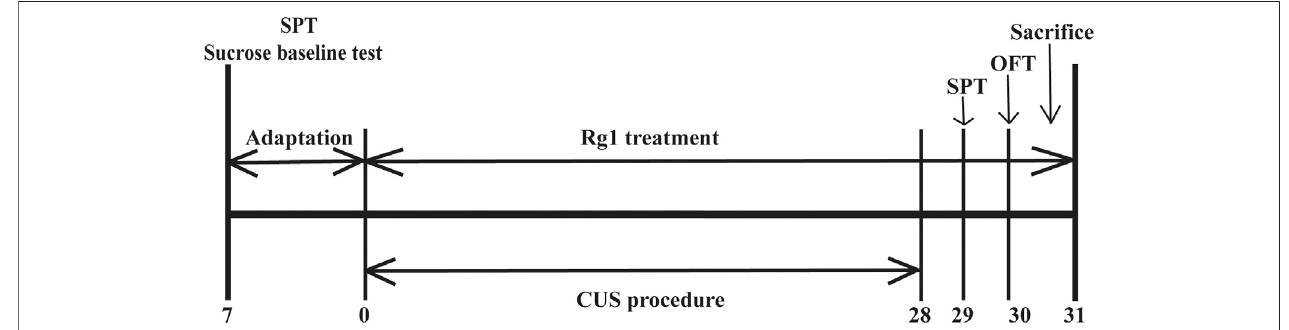
FIGURE1| Theschemeofexperimental designandtimelineforanimals.Rats weresubjectedtoCUSprocedureintheabsenceorpresenceofRg1(40 mg/kg) for 28 days. Behavioral performances of rats were assessed by the SPT and OFT on days 29 – 30, after which the rats were sacri fi ced on day 31 ( n (cid:1) 6 per group). CUS, chronic unpredictable stress; Rg1, ginsenoside Rg1; SPT, sucrose preference test; OFT, open fi eld test.